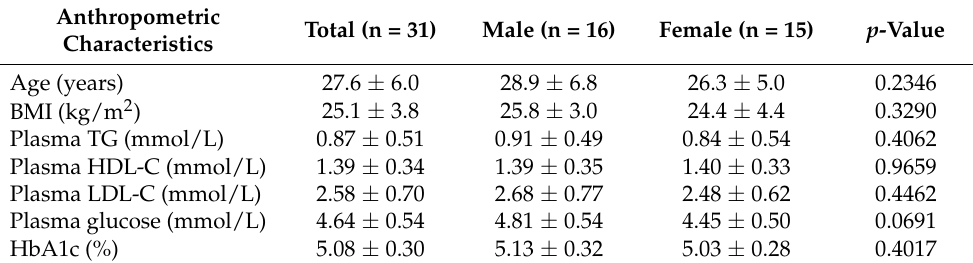
Table 3. Anthropometric characteristics of the participants 1 .